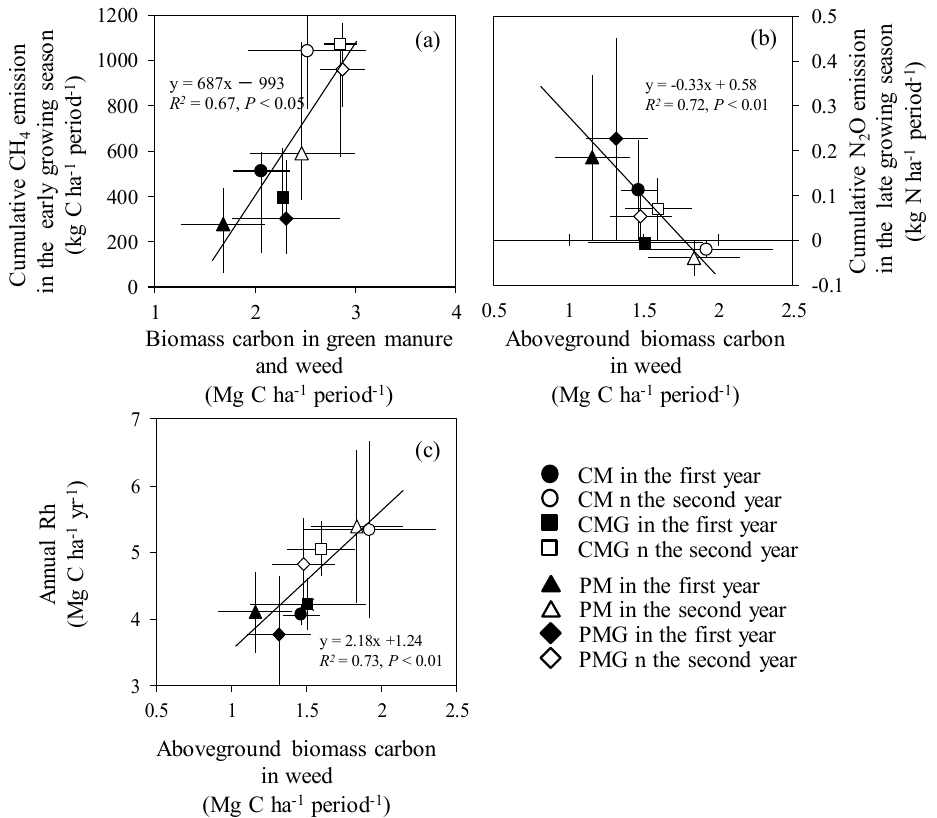
Figure 6. Relationship between biomass carbon in green manure and weed and CH 4 emission in early growing season ( a ), above-ground biomass carbon in weed and N 2 O emission in late growing season ( b ), and biomass carbon in green manure and weed and annual heterotrophic respiration (Rh) ( c ) in the first (2013–2014) and second (2014–2015) years. Error bars represent standard deviations.